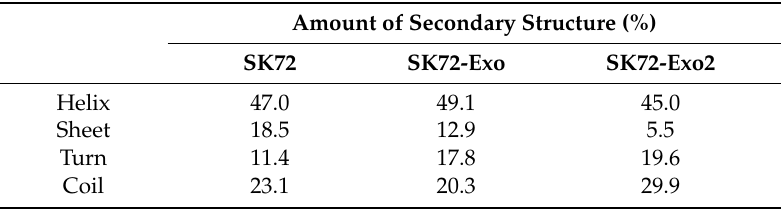
Table 1. Secondary structure content